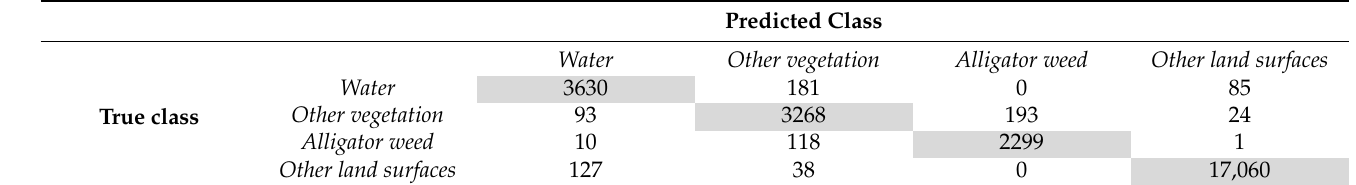
Table 7. Confusion matrix for the 2010 random forest classifier (pixel count from the validation dataset, the grey areas means correctly identified pixels).